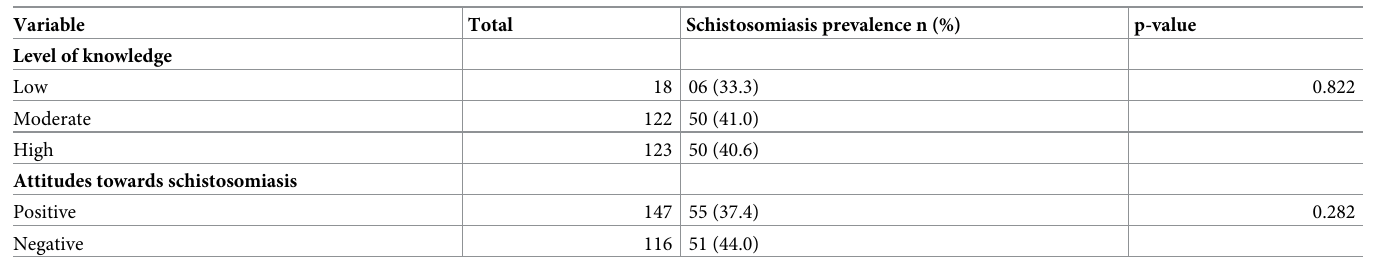
Table 3. Association between knowledge and attitudes with the burden of S . mansoni infection.